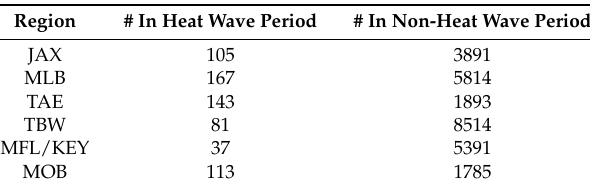
Table 3. Morbidity counts by NWS region 1 .